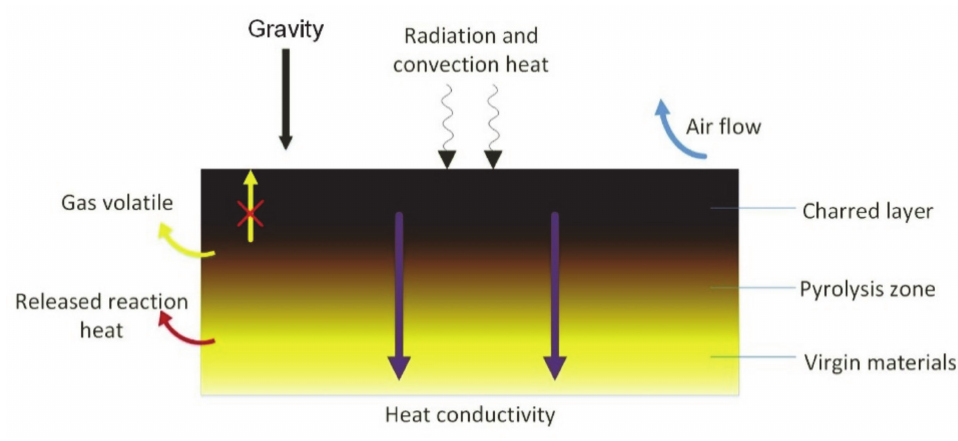
Figure 5. Cone calorimeter heated process of polyurethane under